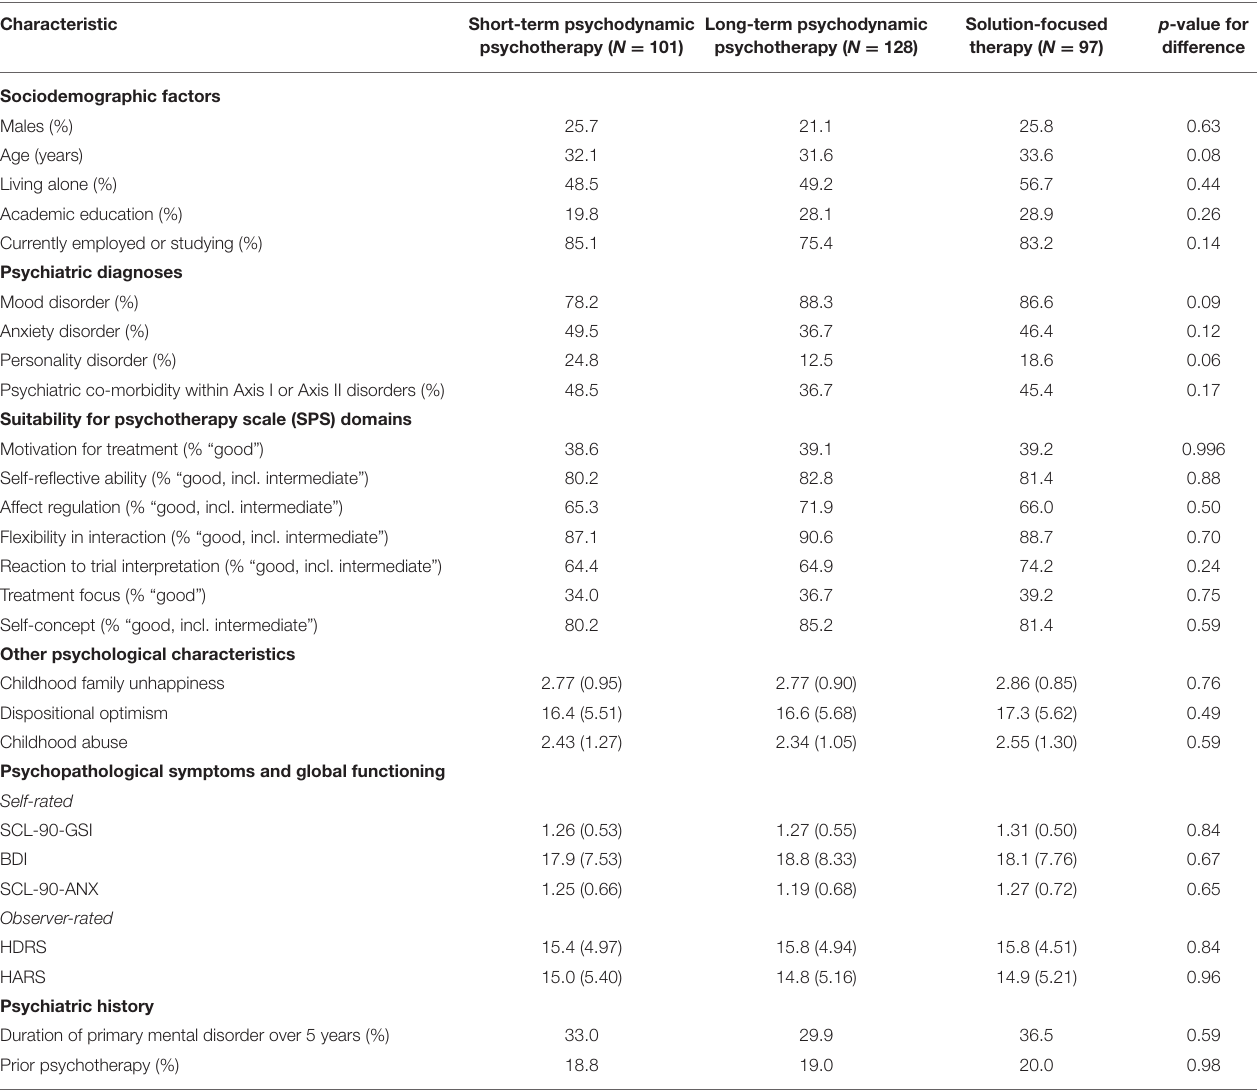
TABLE 1 | Baseline characteristics of the patients by treatment group.